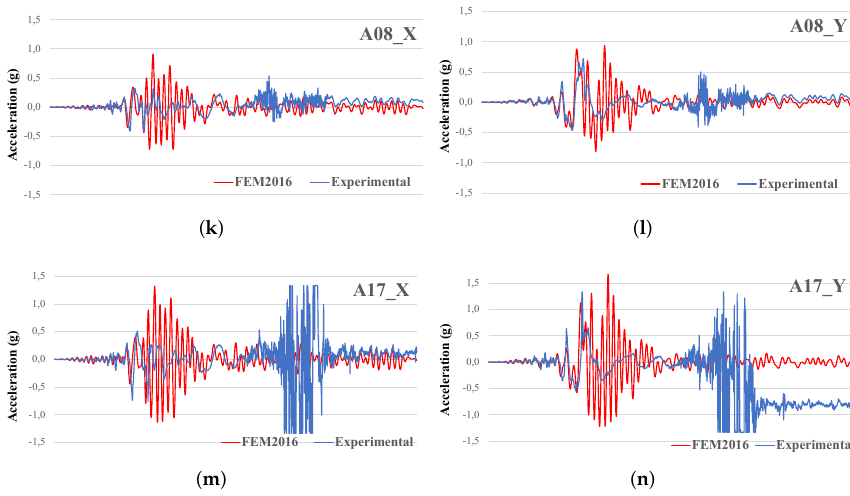
Figure 9. Time histories (time interval 11–22 s) of the recorded accelerations (Experimental), compared to the linear simulations (FEM2016): ( a , b ) Bldg. A lev. 2; ( c , d ) Bldg. A lev. 3 (roof); ( e , f ) Bldg. B lev. 2;